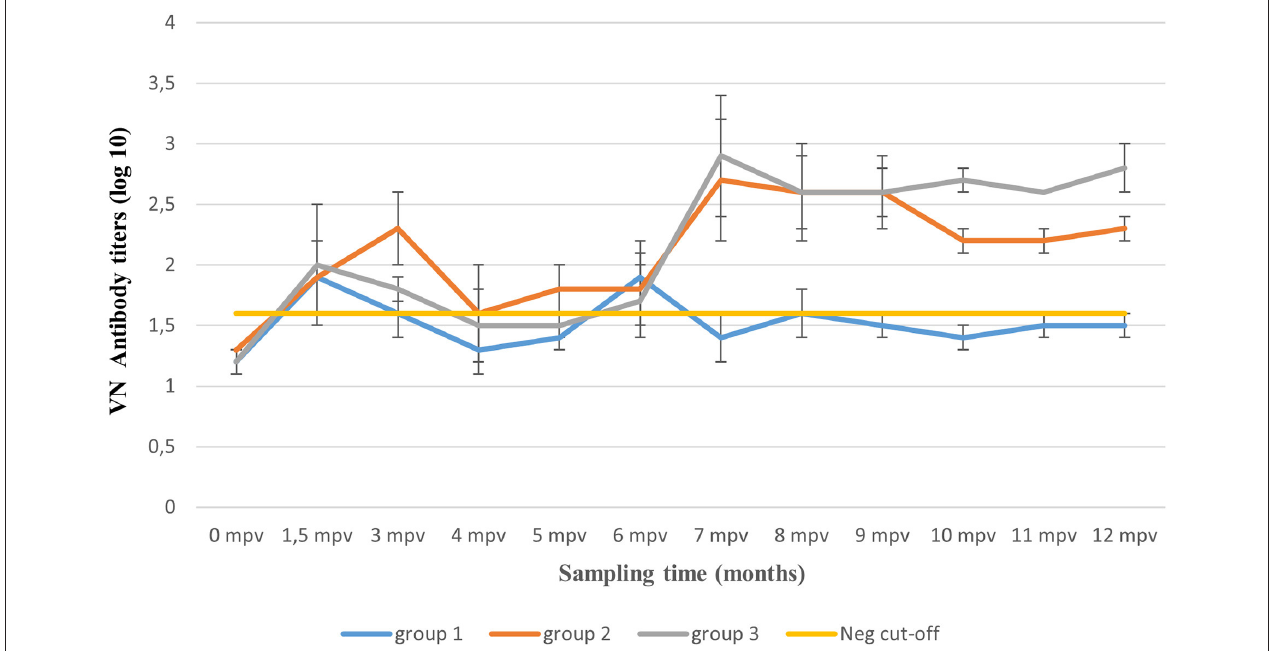
FIGURE 3 | Mean virus neutralizing (VN) antibody titers ( ± SD) over 12 months post-application of three vaccination regimens. The yellow line represents animals’ mean antibody titers ( ≤ 1.6 log10) before vaccination and the VN test’s standard negative control titer.